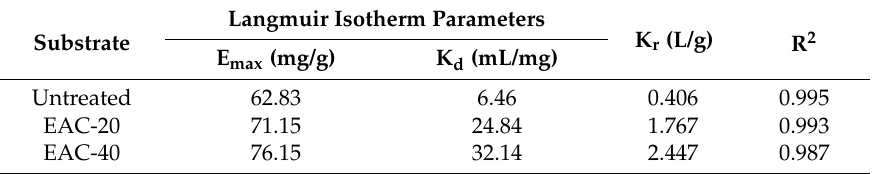
Figure 2. Cellulase adsorption isotherm on poplar wood untreated and pretreated with [Emim]Ac at 90 °C. EAC-20: [Emim]Ac pretreated for 20 min. EAC-40: [Emim]Ac pretreated for 40 min. Table 2. Langmuir isotherm parameters for cellulase binding to poplar wood untreated and pretreated with [Emim]Ac at 90 ◦ C. EAC-20: [Emim]Ac pretreated for 20 min. EAC-40: [Emim]Ac pretreated for 40